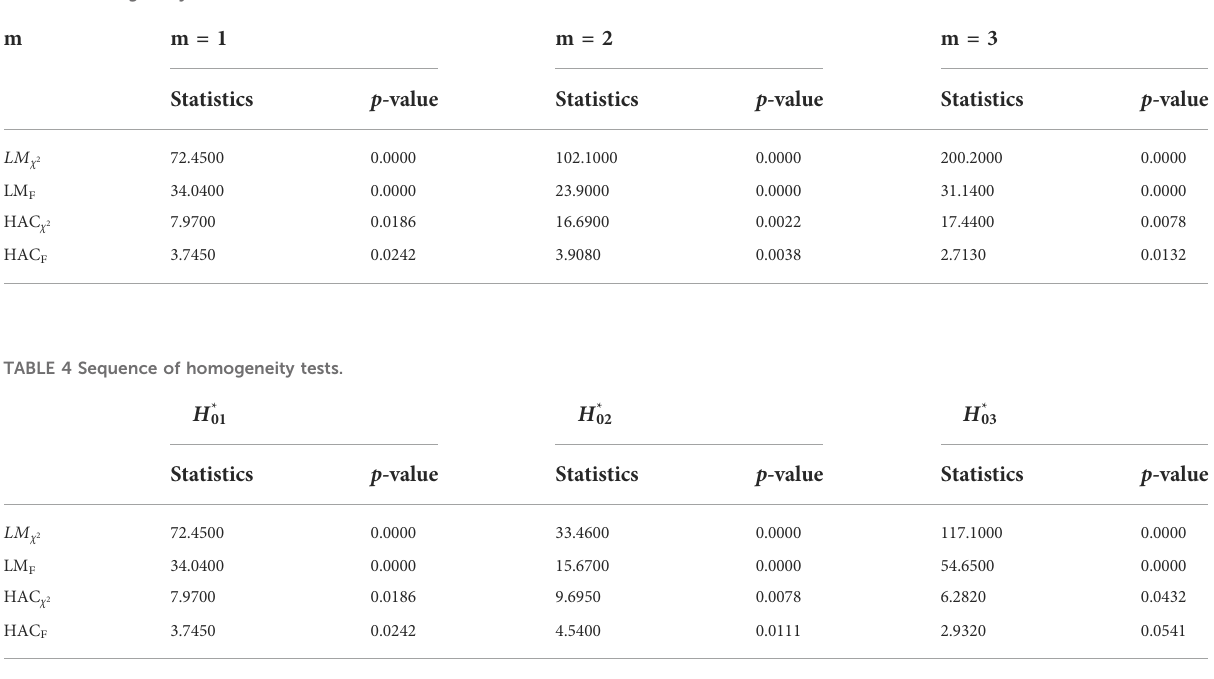
TABLE 3 Homogeneity tests.